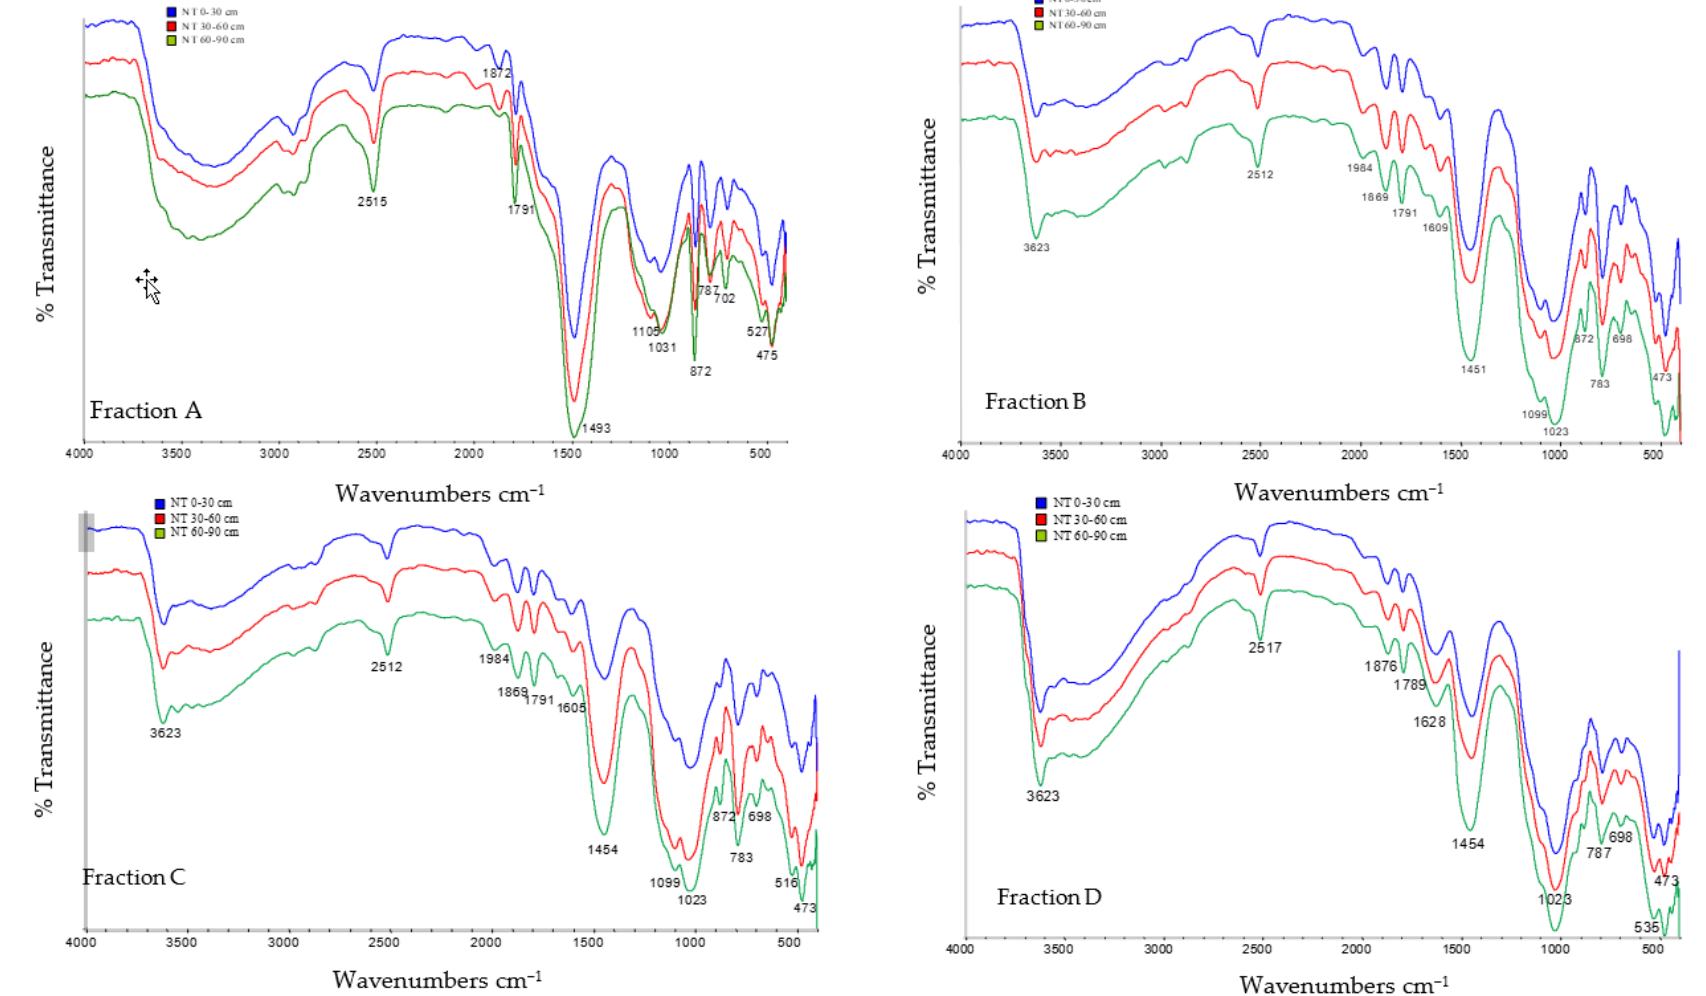
Figure 3. Diffuse reflectance infrared Fourier transform spectra of all soil fractions (A, B, C, and D) isolated from no tillage (NT) treatment at different soil depths.